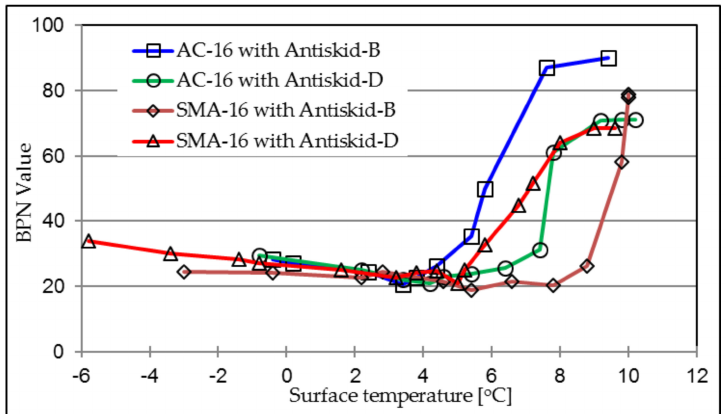
Figure 9. BPN values of investigated antiskid